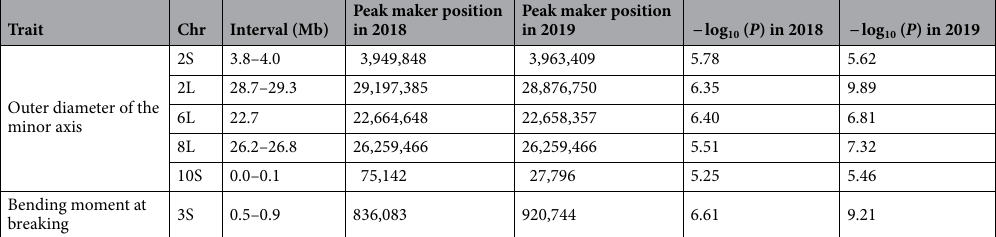
Table 1. Positions of peaks identified in both